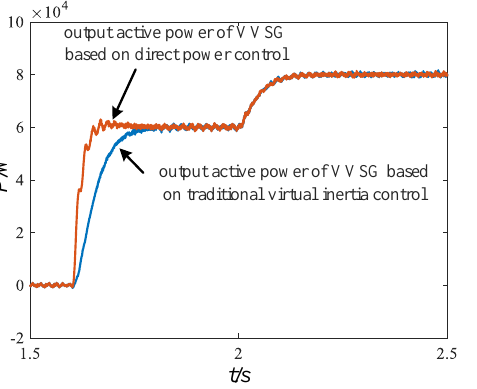
Figure 13. The output active power waveforms of VVSG with grid frequency varies.